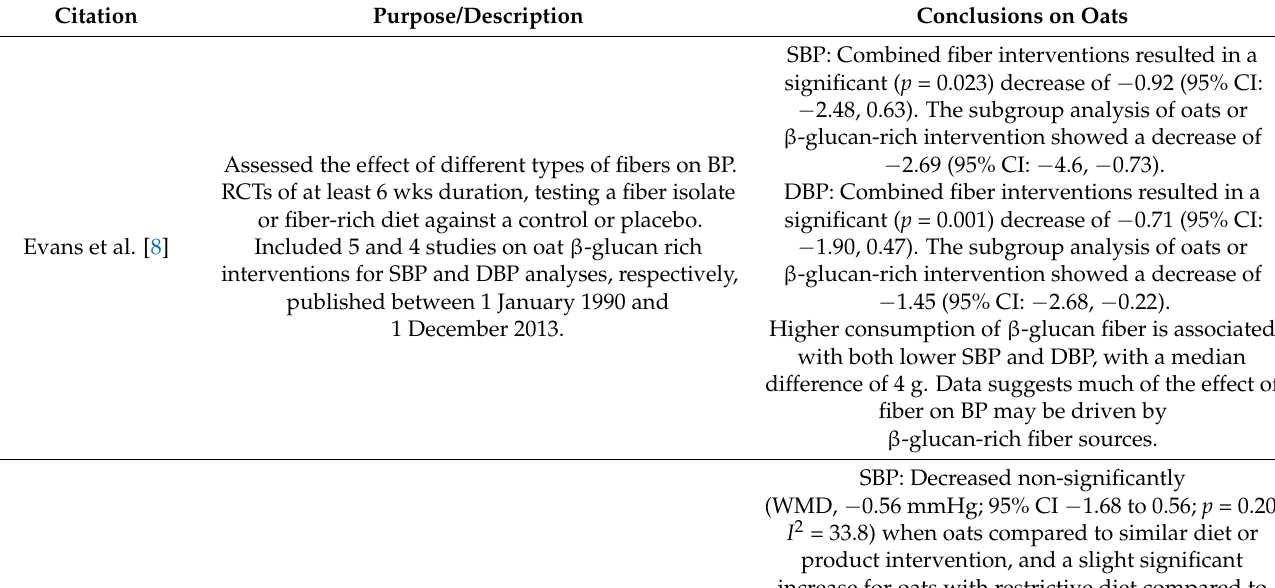
Table 1. Meta-analyses reports on oats and blood